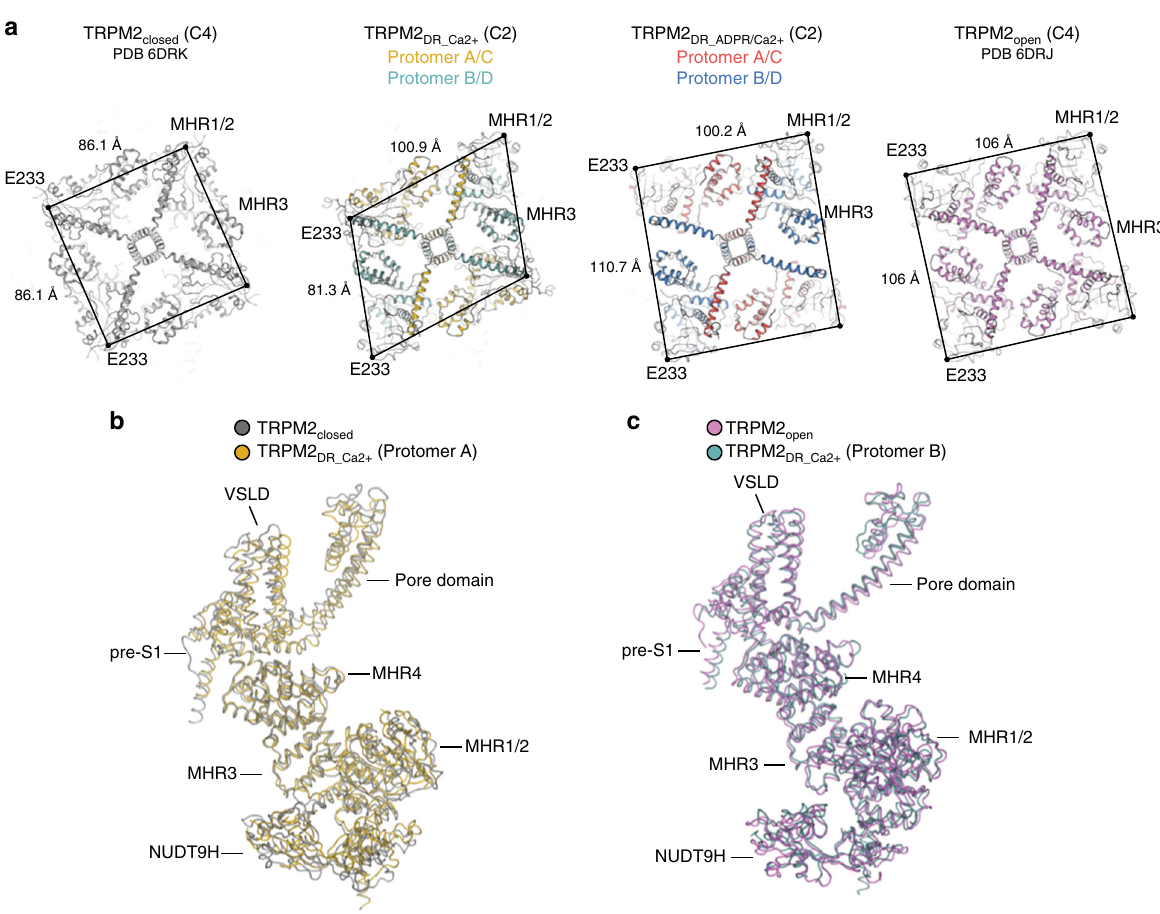
Fig. 3 TRPM2 DR structures in the intermediate states. a Extracellular views sliced through the middle layer of the CDs comprised of the MHR1/2 and MHR3 domains in the TRPM2 closed , TRPM2 DR_Ca2 + , TRPM2 DR_ADPR/Ca2 + , and TRPM2 open structures. Structural alignment (cartoon representation) shows that protomer A in the TRPM2 DR_Ca2 + structure (yellow) resembles the closed conformation in the TRPM2 closed structure (silver, PDB 6DRK) ( b ), while the protomer B (teal) resembles the open conformation in the TRPM2 open structure (violet, PDB 6DRJ) ( c